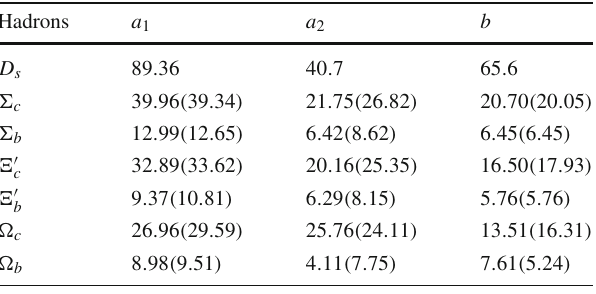
Table 6 Spin-coupling parameters (in MeV) of the heavy meson D s and the SH baryons (cid:7) Q , (cid:2) (cid:2) and (cid:3) Q ( Q = c , b ). The data before Q parentheses are the parameters matched to the measured spectra of the SH baryons shown and the data in parentheses are that computed by the mass scaling Eqs. (46), (47) and